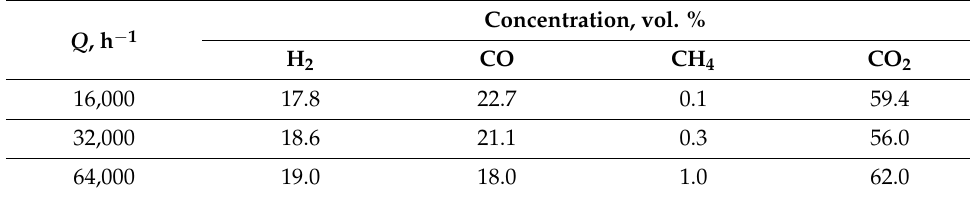
Table 6. Composition of the product gas (Ni-Co, 780 ◦ C).